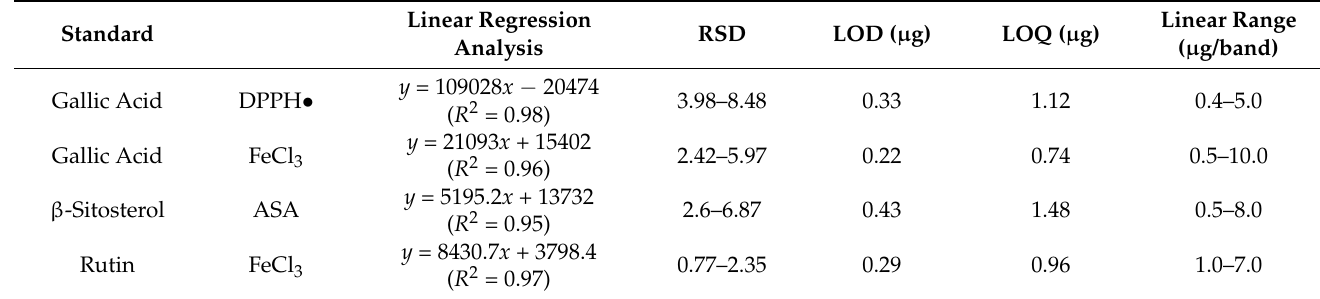
Table 1. Calibration curves and method validation.